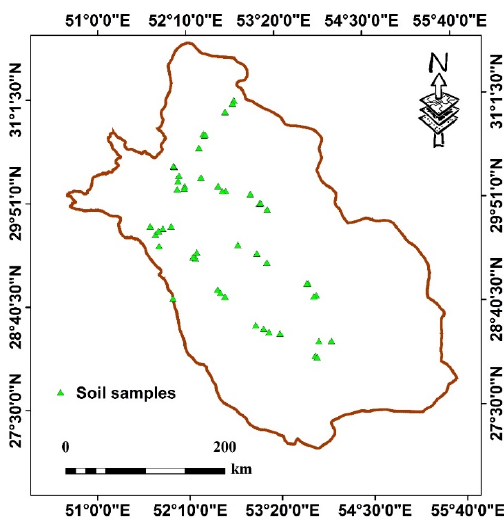
Figure 2. The location of 52 soil samples in the study area.